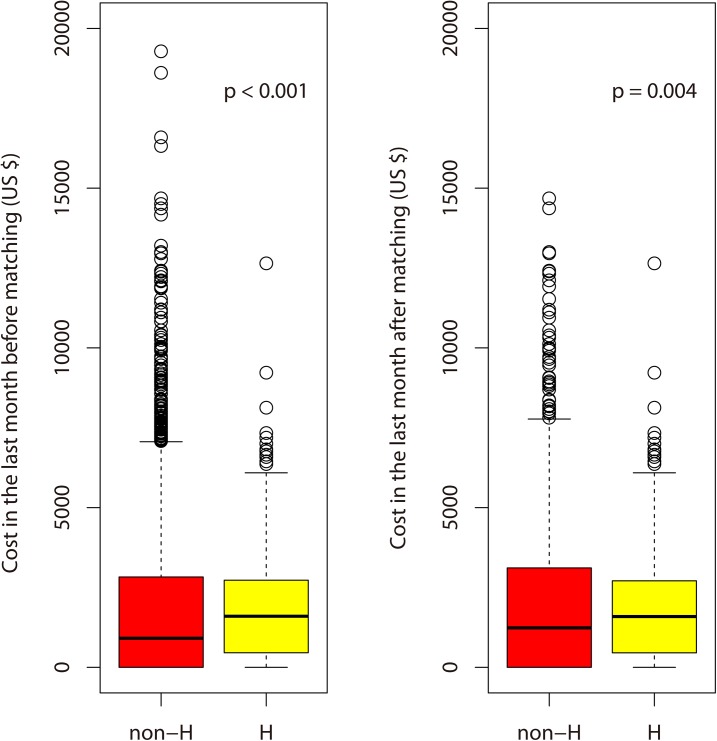
Box plots of costs in the last month of life for patients with advanced lung cancer in the non-H and H groups before and after 2:1 propensity score-matching.The mean values of costs in the last month of life in the non-H and H groups were US $1,821 (median = 910, SD = 2,441) and US $1,839 (median = 1,600, SD = 1,638) before 2:1 propensity-score-matching and US $2,024 (median = 1,236, SD = 2,498) and US $1,838 (median = 1,590, SD = 1,649) after 2:1 propensity-score-matching, respectively.